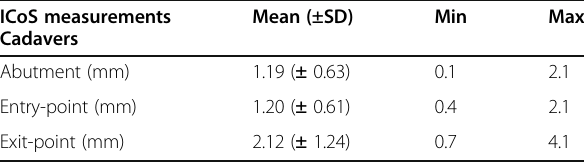
Table 1 Accuracy data. Result of the post-op analysis of the